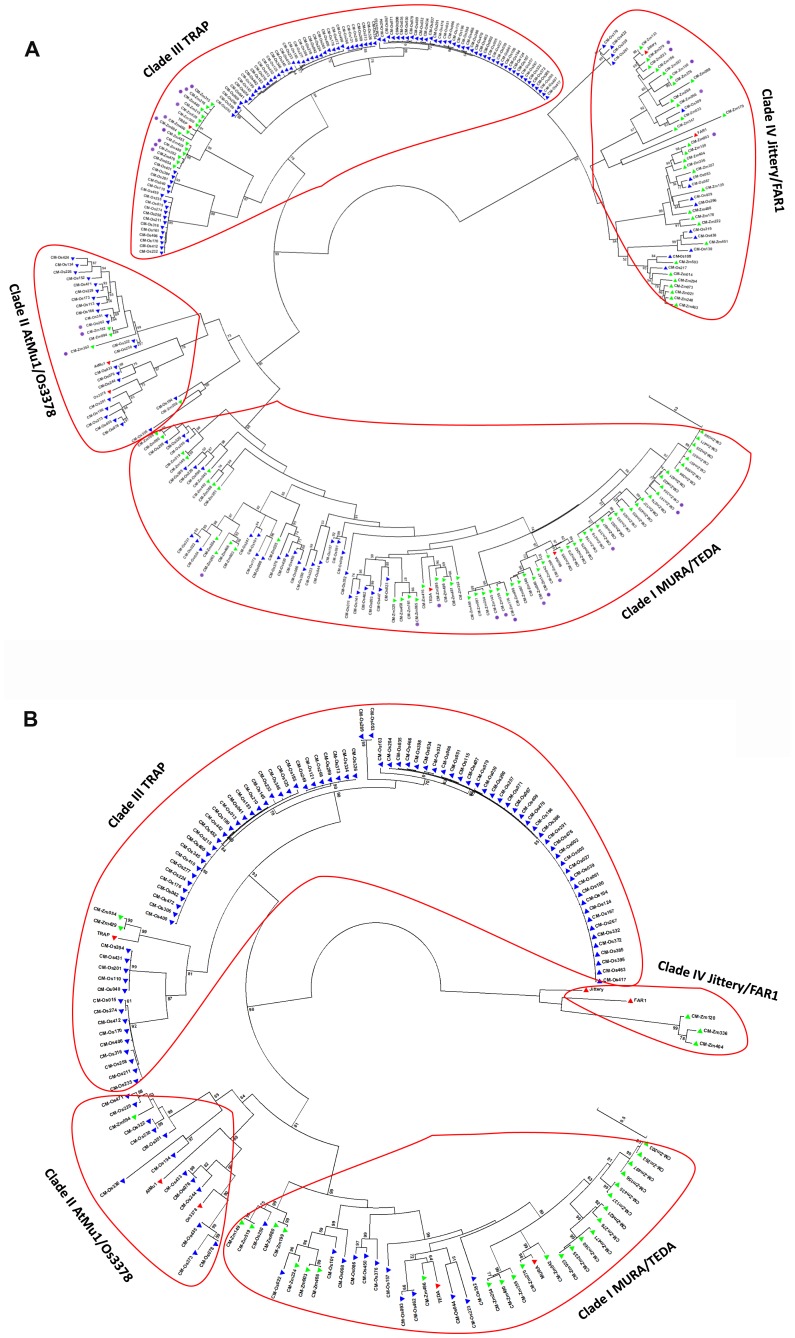
Phylogenetic analysis of the candidate coding-MULEs with DDE domain.A). All representative candidate coding-MULEs containing DDE domain; B). Candidate coding-MULEs with putative intact transposases. Candidate coding-MULEs in maize are denoted by green triangles; those in rice are denoted by blue triangles; known MULE transposases are denoted by red triangles, maize coding-MULEs with nested LTR insertions are denoted with purple round dots.